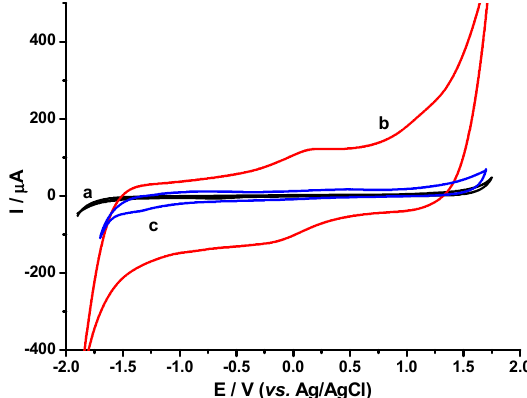
Figure 6. Voltammograms of the GC electrode (a), fCNT/GC (b), and TiO 2 –fCNTs/GC (c) modified electrodes in 0.1 mol ∙ L − 1 phosphate-buffered solution at pH 7 with a scan rate of 100 mV ∙ s − 1 .